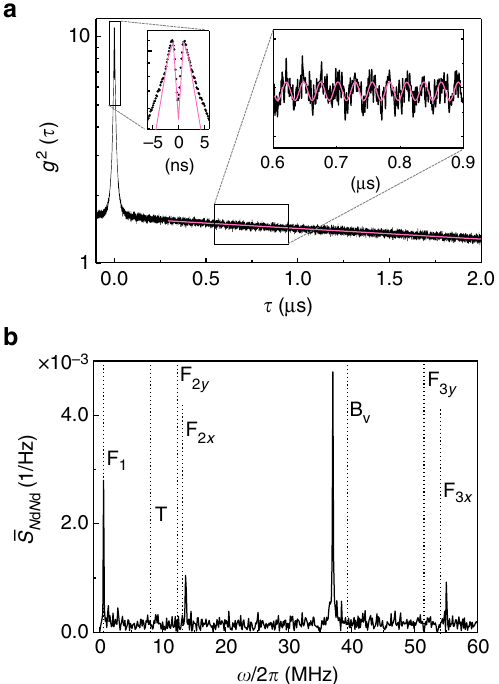
Fig. 3 Quantum dot-mechanical coupling in the photon counting regime. a Auto-correlation function recorded at Δ ’ Γ inh (the entire data extends over 8 μ s). The oscillation in the right inset results from the mechanically Fig. 2 Brownian motion of the fundamental mechanical mode. a Photon induced modulation in count rate (the fi t is a sine with a period of 27 ns). noise power spectral density recorded at detuning Δ = Γ inh (integration The fi t in the left inset ( pink solid line corresponds to a perfect single-photon time 20 min). The resonances correspond to Brownian motion of the fi rst- emitter subject to blinking ( Ω R = γ sp ) and includes the timing jitter of the order fl exural modes. The phonon relaxation rate for mode F 1 x (F 1 y ) is detectors (500 ps). b In black , the noise power spectral density obtained γ π = 220 Hz ( γ π = 230 Hz). The background corresponds to the from the Fourier transform of the auto-correlation measurement. The black m /2 m /2 shot noise level. b Photon noise power A as a function of laser detuning for dotted lines correspond to the resonance frequencies obtained from a F 1 x (pink circles) and F 1 y (green diamonds). The solid lines are fi ts to the experimental data with λ as the only free parameter. The error bars correspond to the uncertainty on the quantum dot laser detuning over the 20 min measurement